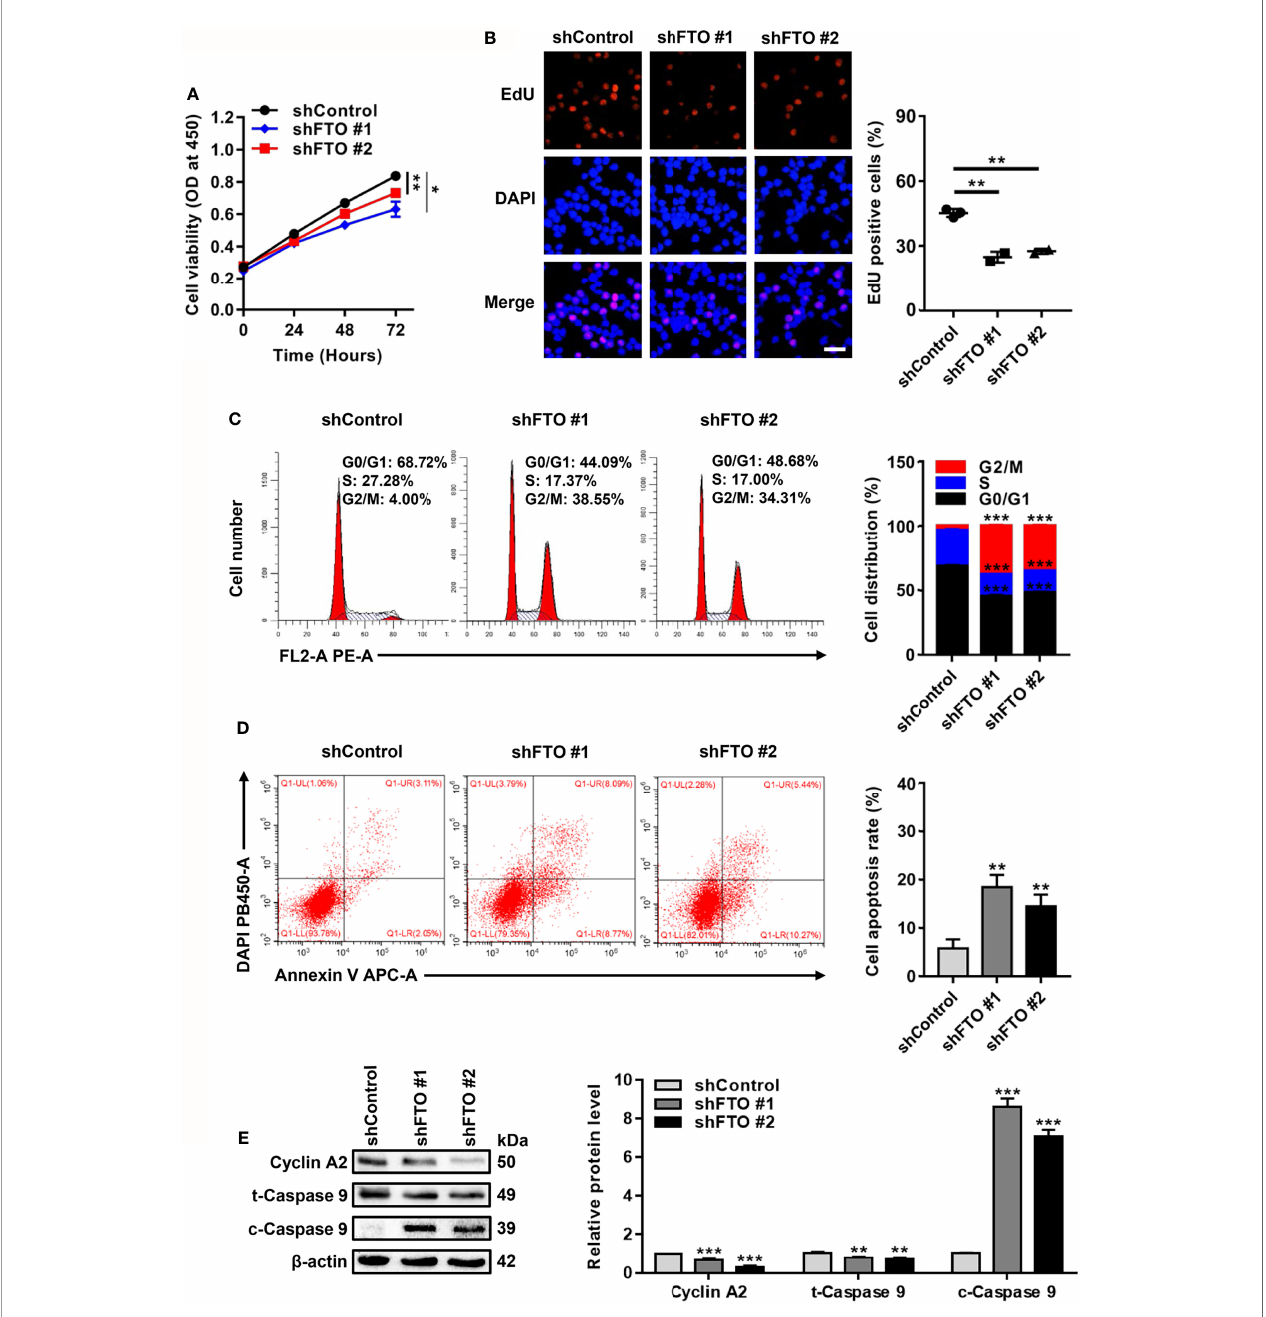
FIGURE 3 | FTO Promotes Leukemic Cell Proliferation by Facilitating Cell Cycle and Suppressing Cell Apoptosis. (A) CCK-8 analysis of cell growth in the FTO- silenced OCI-AML3. (B) EdU analysis of cell proliferation in the FTO-silenced OCI-AML3 cells. The bar graph showed the percentage of EdU positive cells. Scale bar: 50 m m. (C) Flow cytometric analysis of cell cycle distribution in FTO-silenced OCI-AML3 cells. The bar graph showed the percentage of G0/G1, S, and G2/M phase cells. (D) Cell apoptosis was measured by fl ow cytometric analysis of the Annexin V/DAPI stained cells. The bar graph showed the cell apoptosis rate. (E) Western blot analysis of Cyclin A2, t-Caspase 9, and c-Caspase 9 protein level in the FTO-silenced OCI-AML3. b -actin was used as the internal control. The bar graph showed the relative level of protein. Data were presented as the mean ± SD of three independent experiments. * P < 0.05, ** P < 0.01, *** P <